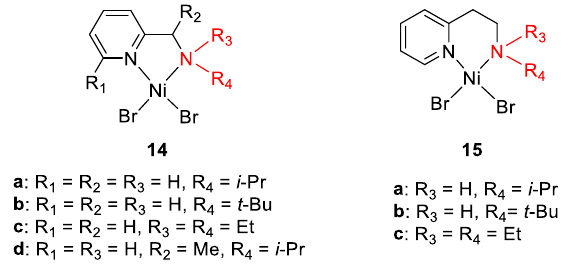
Figure 10. The α - and β -types of amine – pyridine nickel complexes.